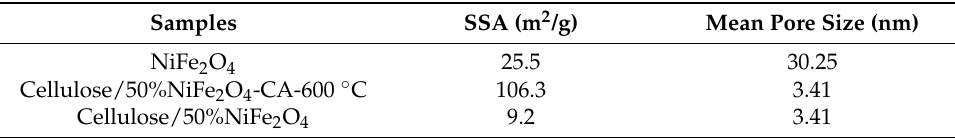
Table 2. The experiment results of N 2 isothermal adsorption/desorption.